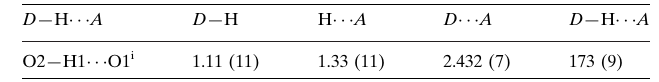
Hydrogen-bond geometry (A˚ , (cid:3)